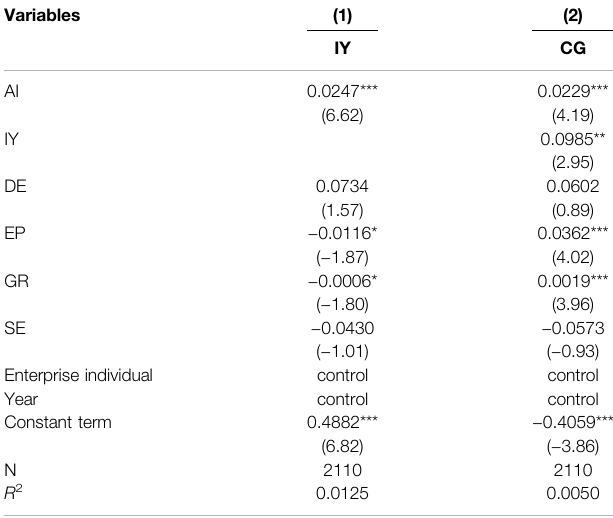
TABLE 7 | The mediation effect test of information symmetry.